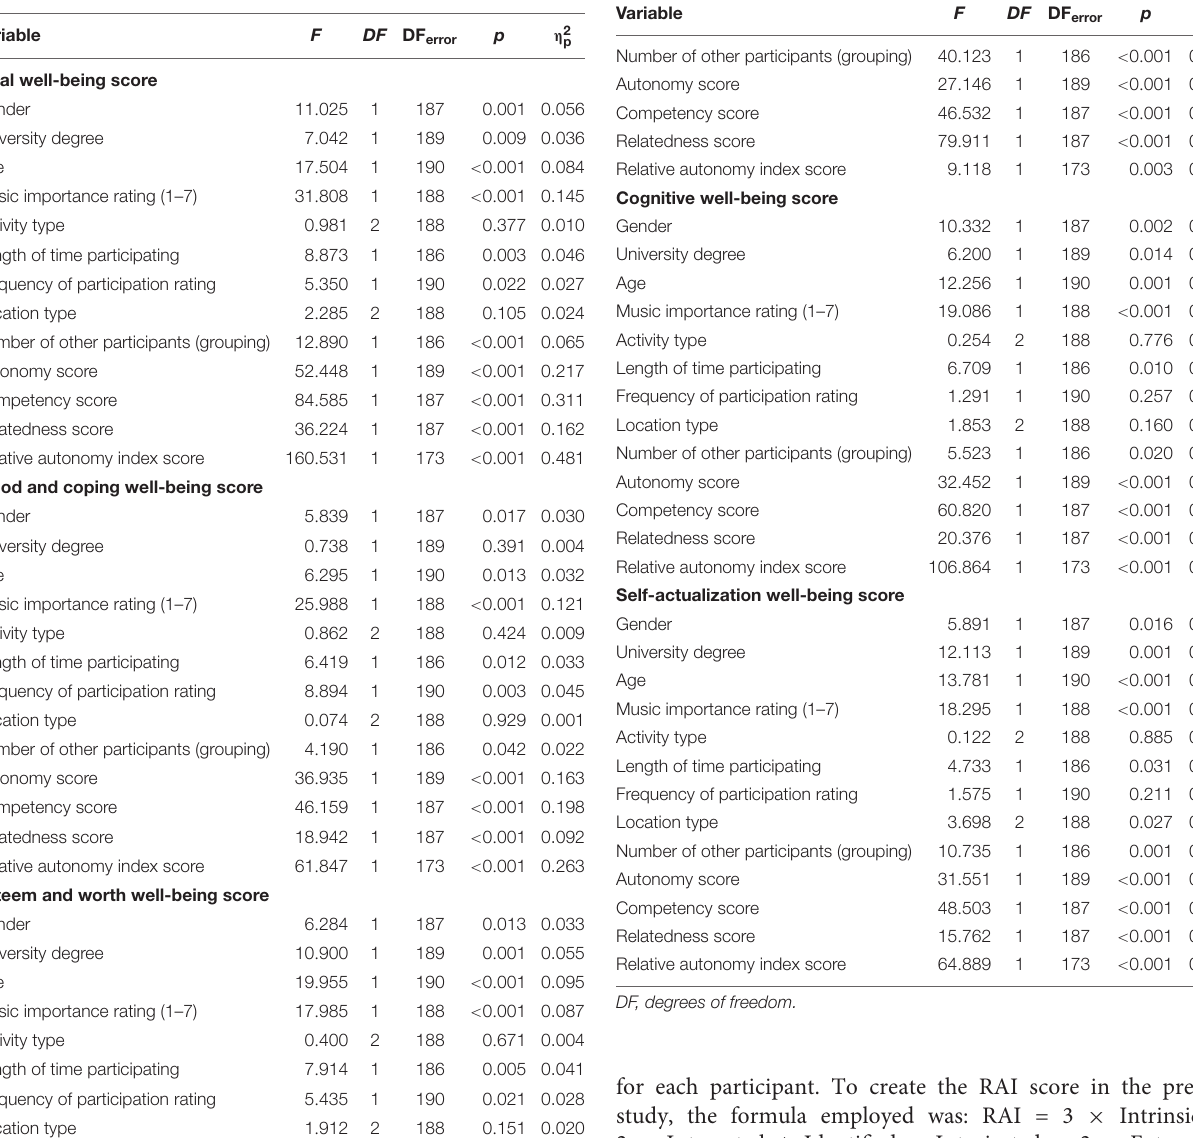
TABLE 1 | Results of the first step of the GLMM analyses concerning well-being